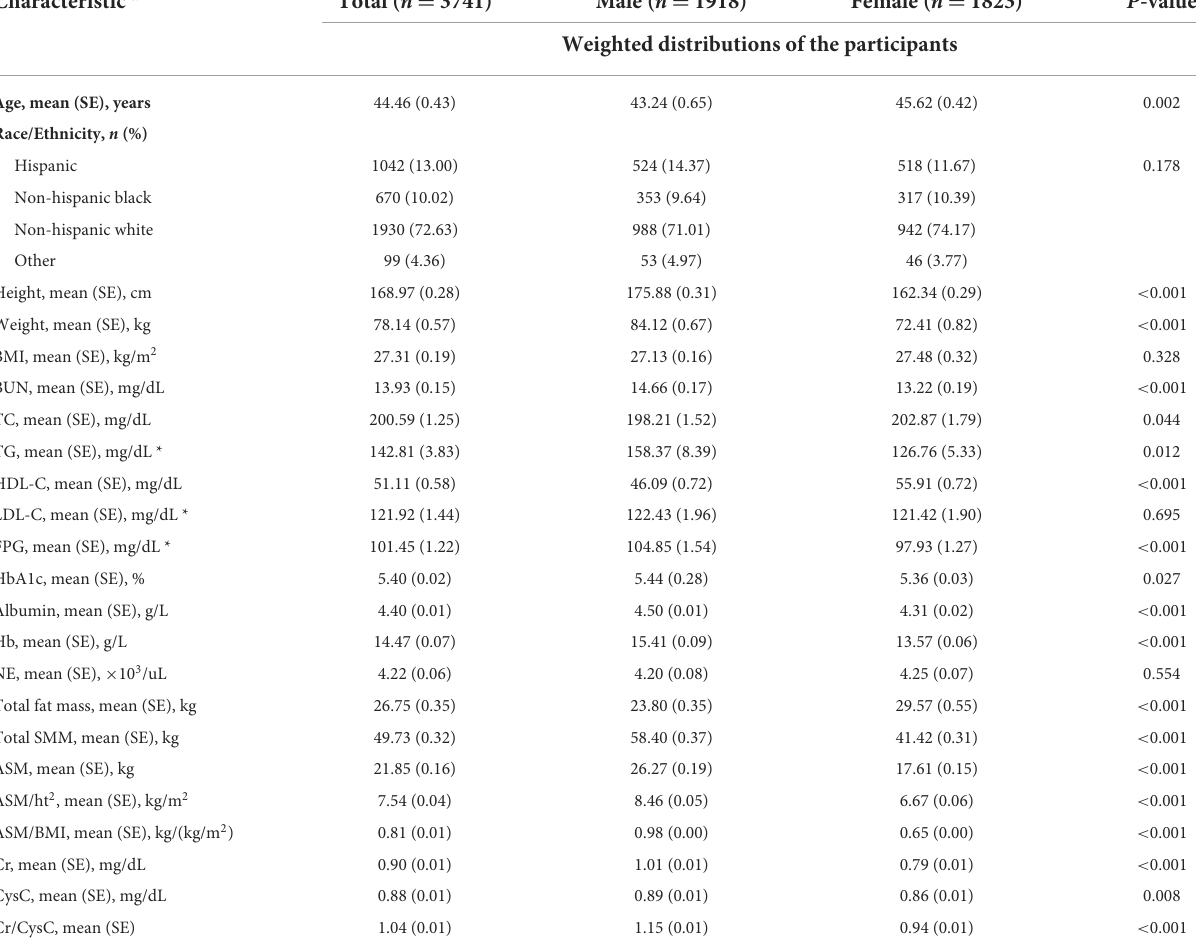
TABLE 1 Characteristics of the study population according to sex (weighted). Characteristic a P -value Weighted distributions of the participants